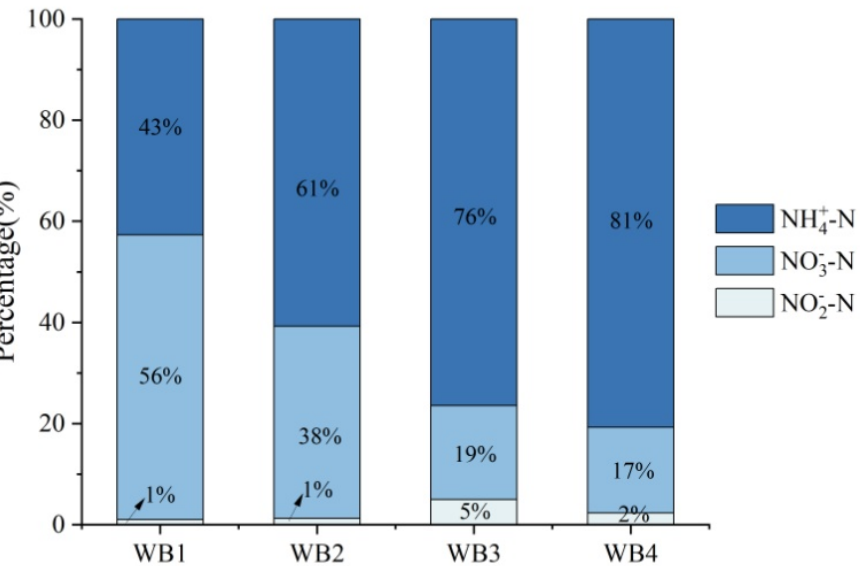
Figure 6. Mean proportions of different forms of inorganic nitrogen in the groundwater in the riparian observation wells during the study period from 21 to 23 October 2021.